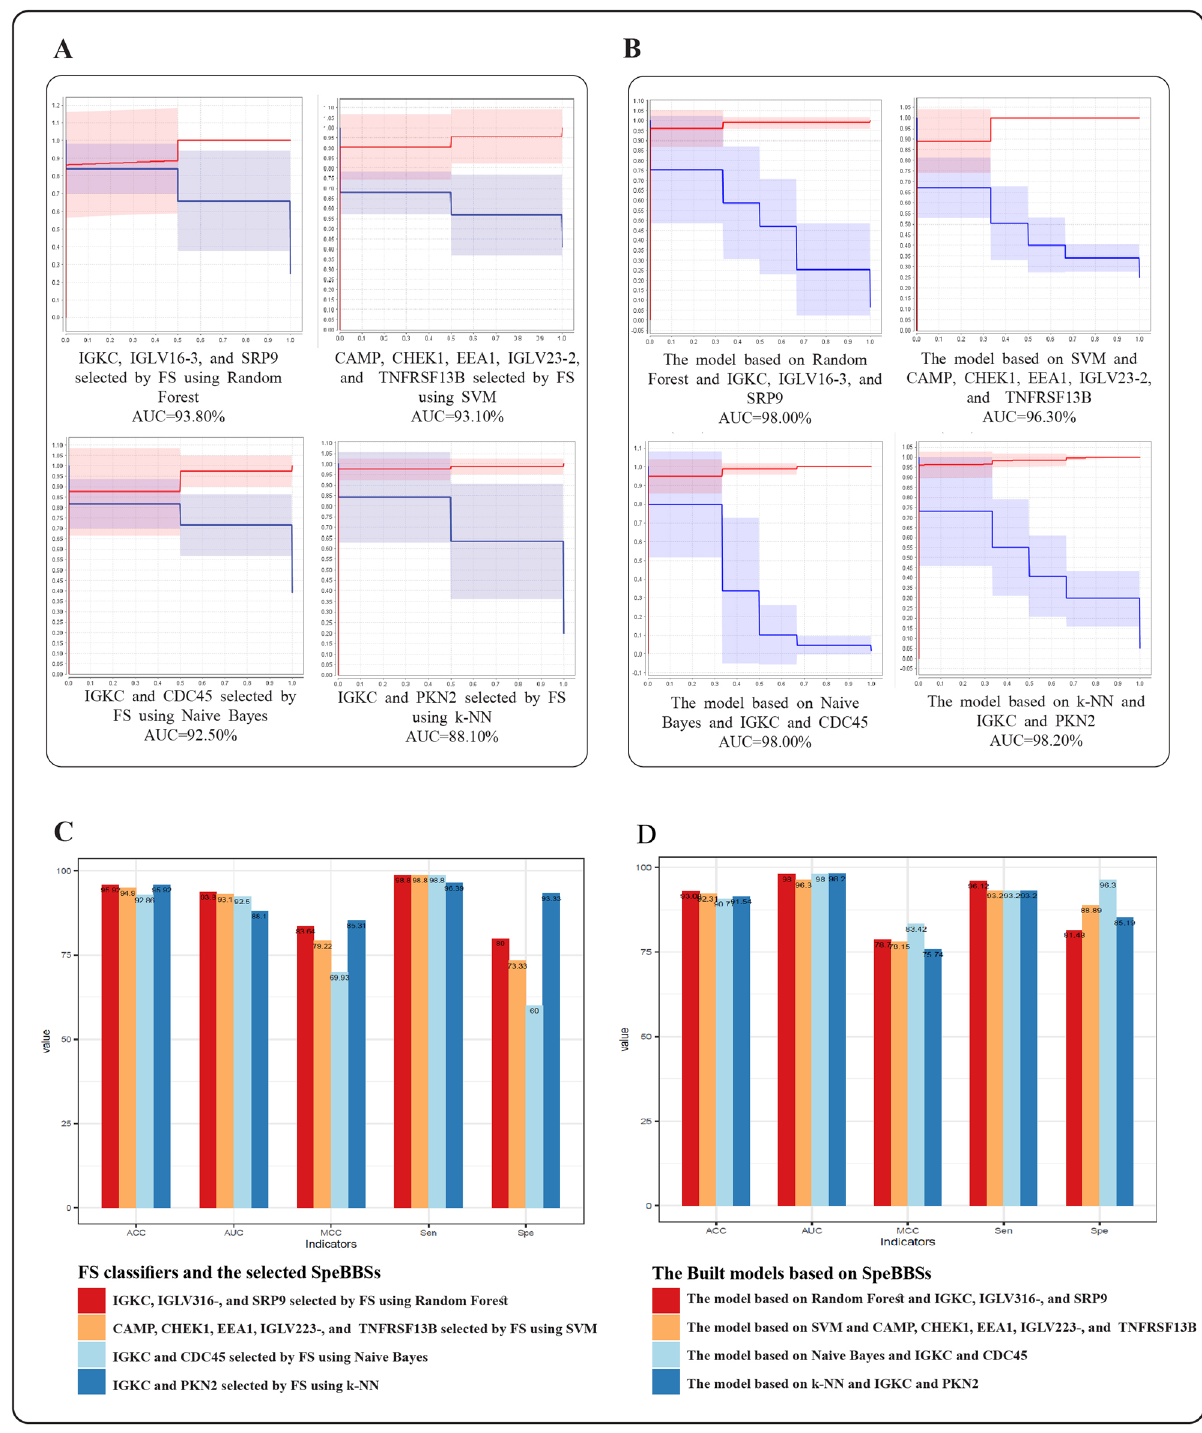
Figure 5. The ten-fold cross-validation results of the feature selection method in choosing SpeBBSs and the constructed machine learning models; ( A ) ROC curves representing classification ability of the feature selection method by the four classifiers on GSE166190 dataset (the feature selection dataset); ( B ) ROC curves representing classification powers of the constructed models based on the selected SpeBBSs and corresponding algorithms (the same algorithms that were applied in feature selection step) on Bibert et al.’s dataset A (the validation dataset). These ROC curves show ROC (red lines) at various threshold settings (blue lines). In the ROC curves, the x-axis shows 1-specificity, and the y-axis shows sensitivity. ( C ) Four measures indicating the classification power of the feature selection method by the four classifiers on GSE166190 dataset (the feature selection dataset); ( D ) Four measures indicating the power of constructed models based on the selected SpeBBSs and the corresponding algorithms (the same algorithms that were applied in feature selection step) on Bibert et al.’s dataset A (the validation dataset). FS: feature